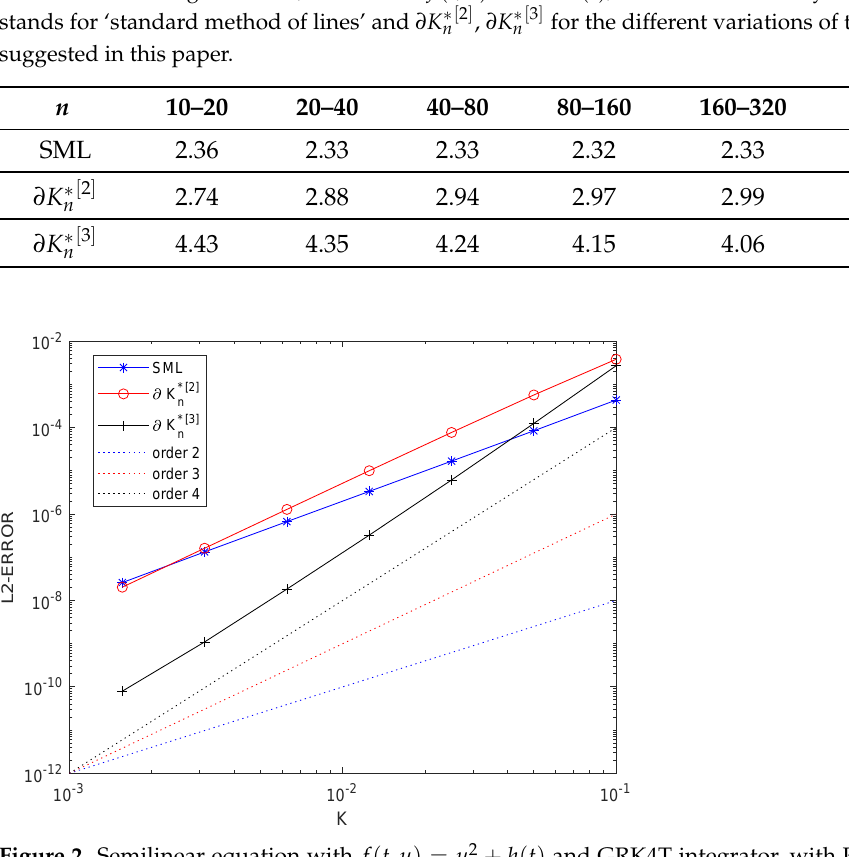
Figure 2. Semilinear equation with f ( t , u ) = u 2 + h ( t ) and GRK4T integrator, with Robin bound- ary